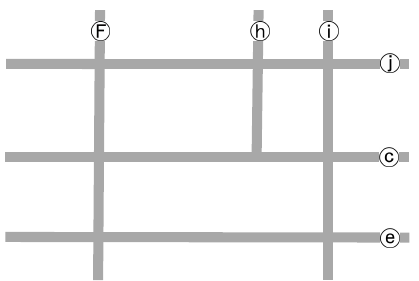
Figure 16. A result of the road network generalization by combining the pairing primary